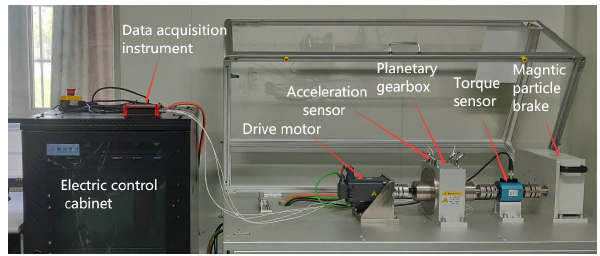
Figure 10. Vibration test bench.